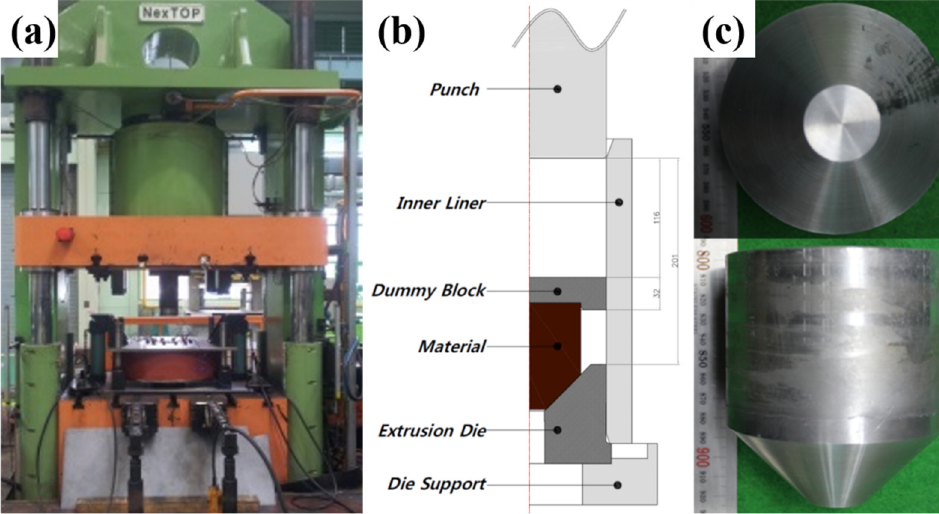
Figure 2. ( a ) Hydro co-extrusion equipment (HCE), ( b ) schematic diagram of HCE chamber, and ( c ) shape of prepared specimen and its dimensions for HCE process.